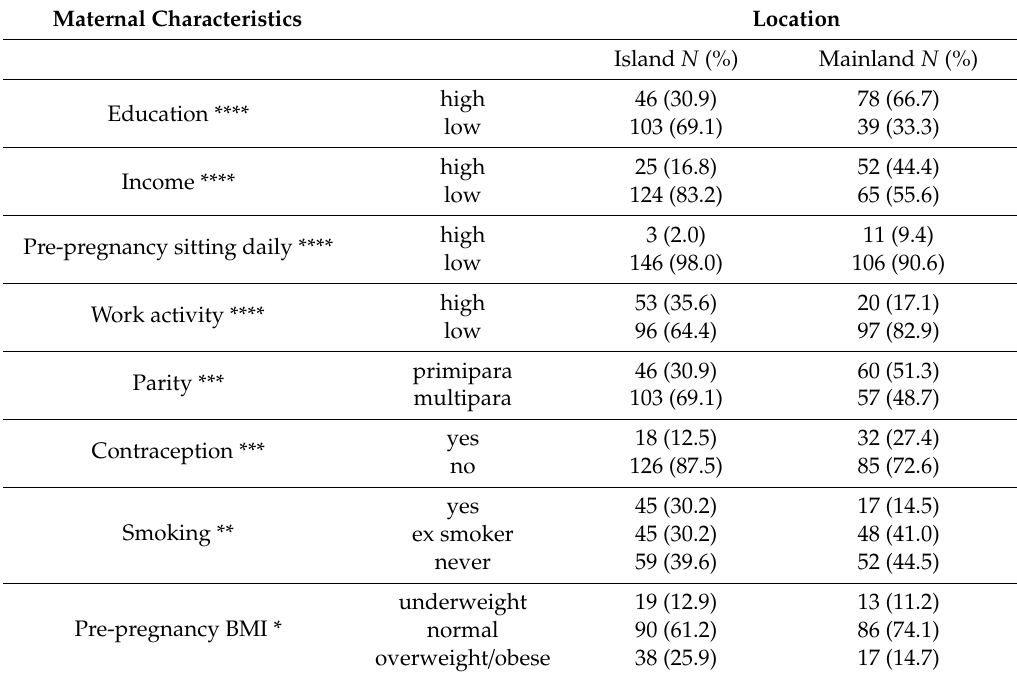
Table 2. Baseline characteristics of Croatian Islands’ Birth Cohort Study (CRIBS) participants by place of residence (* p = 0.056, ** p < 0.05, *** p < 0.01, **** p < 0.001). The results are obtained by means of the Mann–Whitney U (MWU)